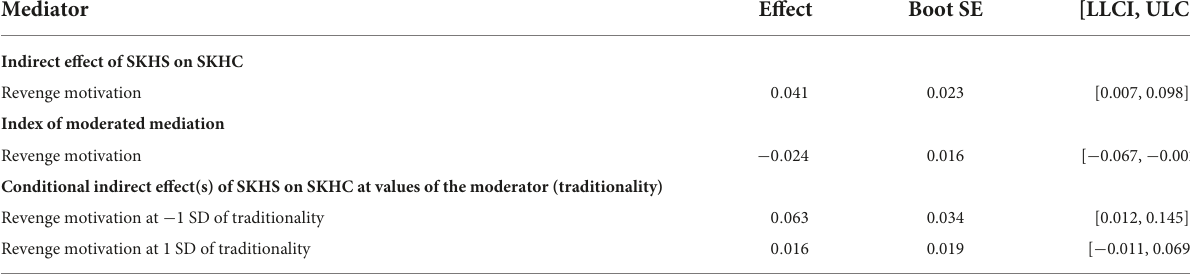
TABLE 4 The results of mediation effect and moderated mediation effect.